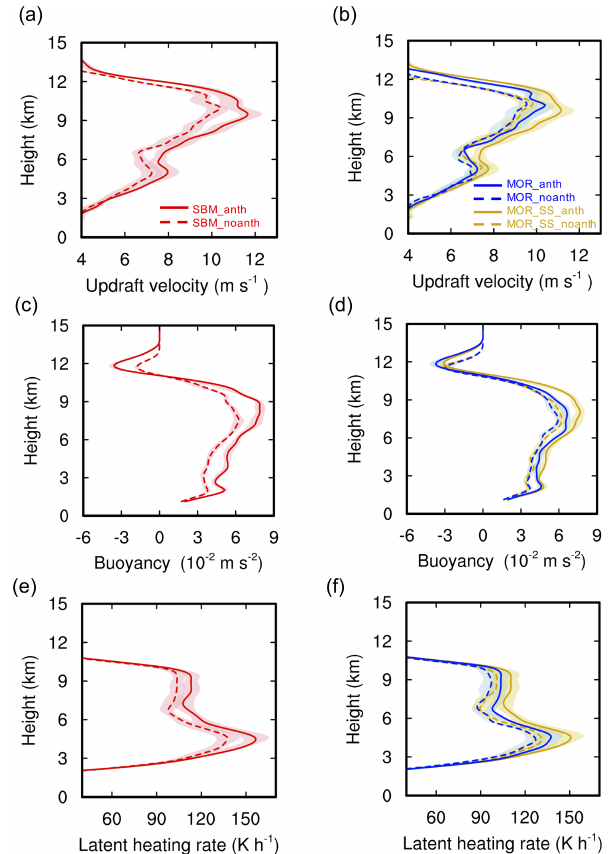
Figure 11. Vertical profiles of (a, b) updraft velocity (unit:ms − 1 ), (c, d) buoyancy (unit: ms − 2 ), and (e, f) the total latent heating rate (unit: Kh − 1 ) averaged over the top 25 percentiles (i.e., from the 75th to the 100th percentile) of the updrafts with velocity greater than 2ms − 1 from the simulations SBM_anth and SBM_noanth (red), MOR_anth and MOR_noanth (blue), and MOR_SS_anth and MOR_SS_noanth (orange) over the study area (red box in Fig. 7) during the strong convection period (20:00–23:00UTC on 19 June 2013). The results are the three ensemble means. The shaded areas mark the spread of the ensemble members.